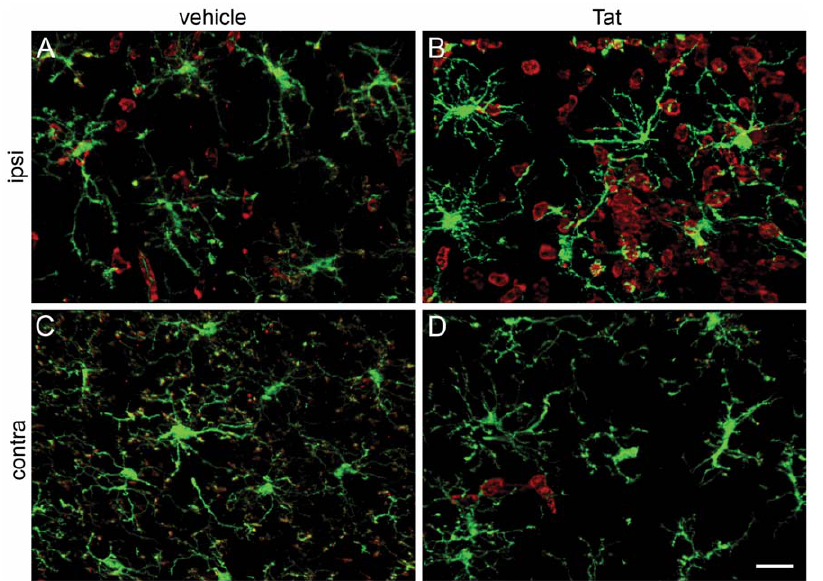
Figure 4. High resolution micrographs confirm lack of amoeboid microglial morphology following exposure to Tat in irradiation chimera. Montage of high resolution micrographs illustrating the microglia remain in a ramified morphology 24 hours after Tat (Panels B, D) or control vehicle (Panels A, C) injection into right hippocampus in CX 3 CR1/GFP + / 2 hosts engrafted with congenic CD45.1 bone marrow. Shown are CD11b + cells (red) and GFP + microglia (green). While thickened processes are frequently observed, there is no evidence of amoeboid microglial morphology. Panels A and B were taken from an area of the hippocampus near the injection site of vehicle and Tat, respectively, and C and D were from the corresponding area of the hippocampus contralateral to the injection site of vehicle and Tat, respectively. All experimental and control groups, n=3 independent replicates. Scale bar=20 m m.